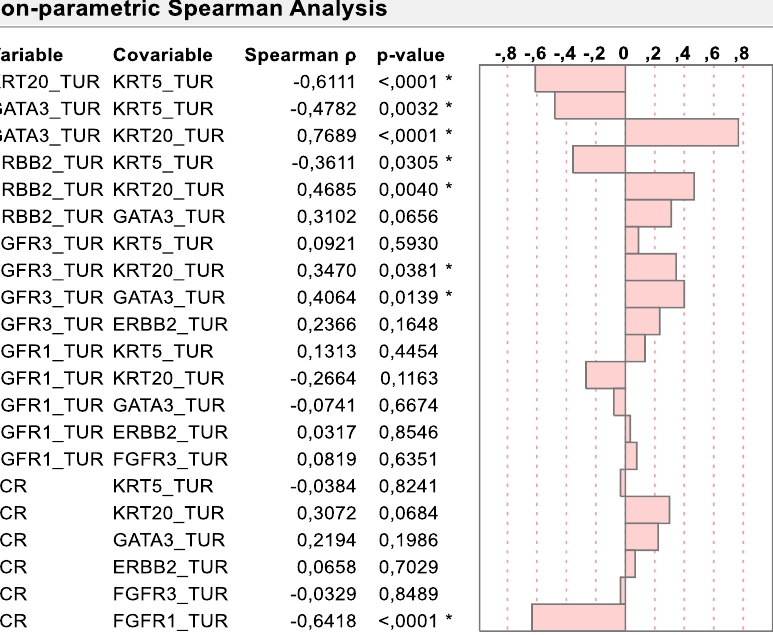
Figure 3. Spearman correlation of KRT5, KRT20, GATA3, ERBB2, FGFR3 and FGFR1 mRNA with dichotomized pCR status. * p < 0.05